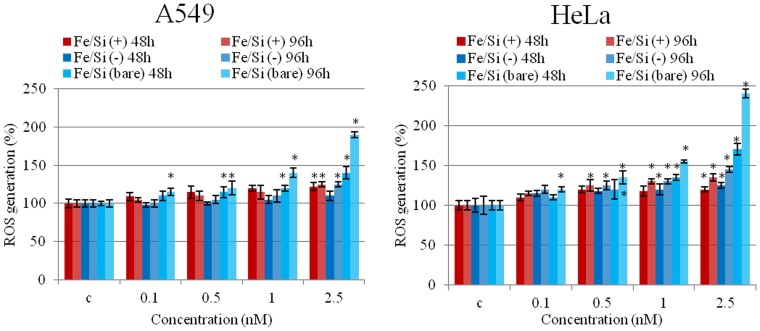
Effect of bare and passivated Fe3O4/SiO2 NPs on the ROS level in two cell lines (A549 and HeLa).Cells were treated with different concentration (0.1, 0.5, 1, 2.5 nM) of NPs for 48 and 96 h and ROS levels were evaluated by DCFH-DA assay. Percent ROS generation of nanoparticle-treated cells is expressed relative to non-treated control cells. As a positive control (P), cells were incubated with 500 µM H2O2 (not shown). Data are reported as mean ± SD from three independent experiments; *P < 0.05 compared with control (n =  8).